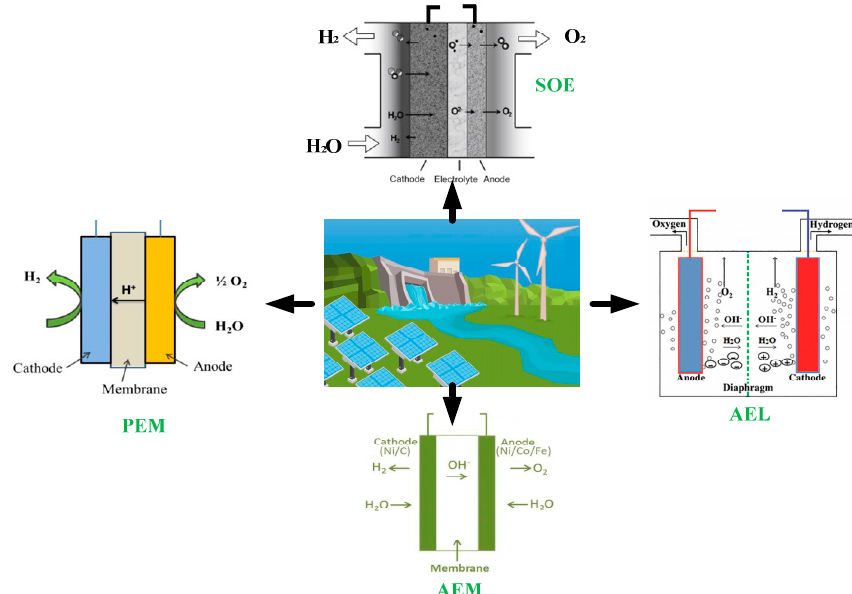
Figure 6. Water electrolysis processes to generate hydrogen.